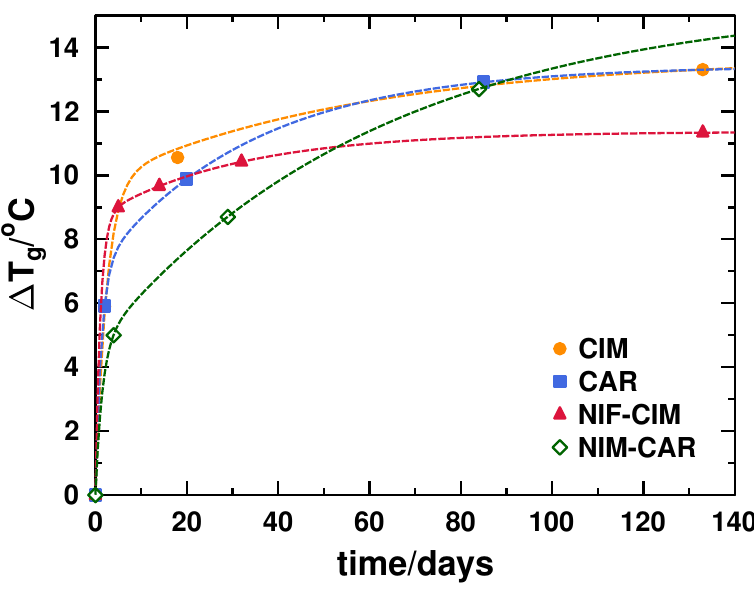
Figure 7. Behavior of glass transition temperature ( ∆ T g is the difference between T g of stored sample and T g of freshly prepared sample, t = 0d) as a function of storage time.